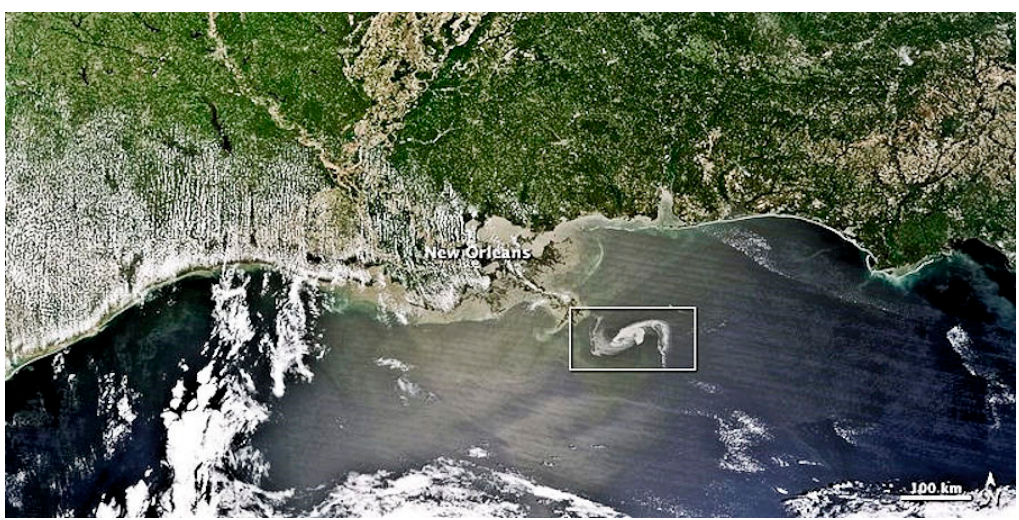
Figure 1. An example image from MODIS during the DWH (Deepwater Horizon) spill in the U.S. Gulf of Mexico. The MODIS sensor is on the NASA Aqua satellite. The oil slick is shown by the white rectangle. Note the many clouds in the image. (Photo from NASA website, www.nasa.gov).